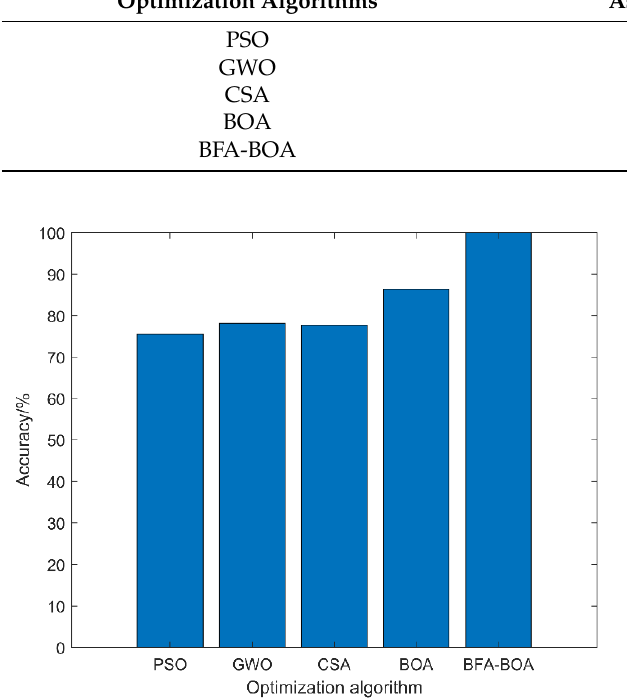
Figure 14. Graph of the evaluation results under different optimization algorithms.